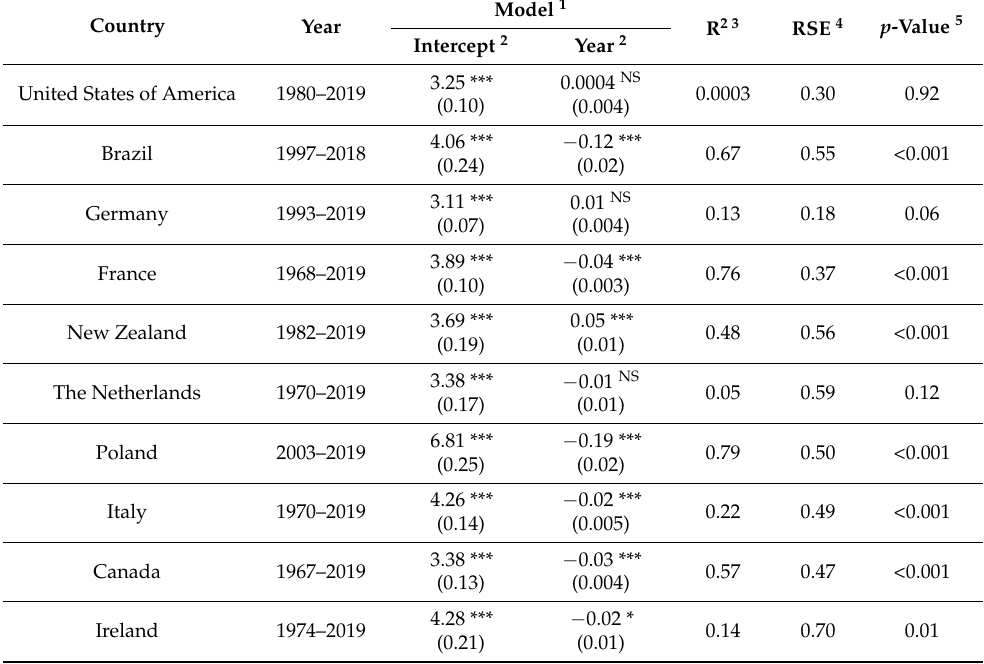
Table 3. The linear trend of the length of productive life (year) in each country. The list of countries is limited to the world’s top high milk-producing countries for which we were able to provide sufficient and reliable data on the length of productive